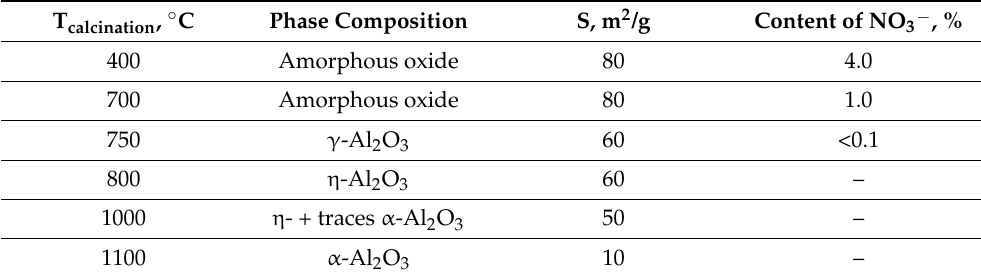
Table 4. Thermal decomposition of amorphous aluminum compounds (S—specific surface area) [33,34]. T calcination , ◦ C Phase Composition S, m 2